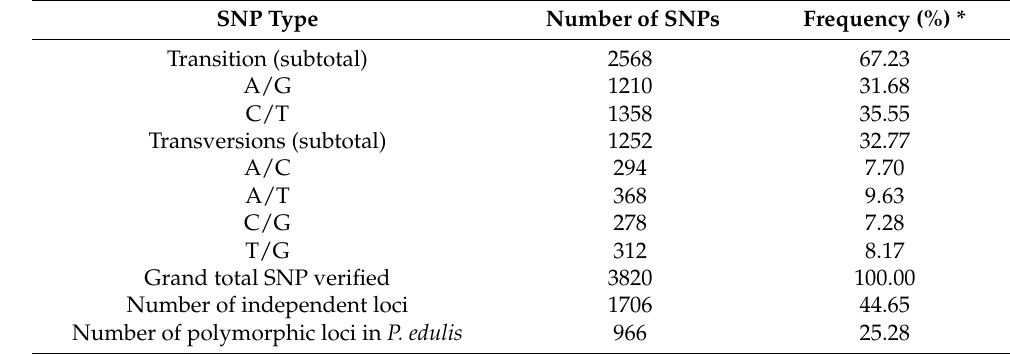
Table 1. Number of single-nucleotide polymorphism (SNPs) and frequency of transitions